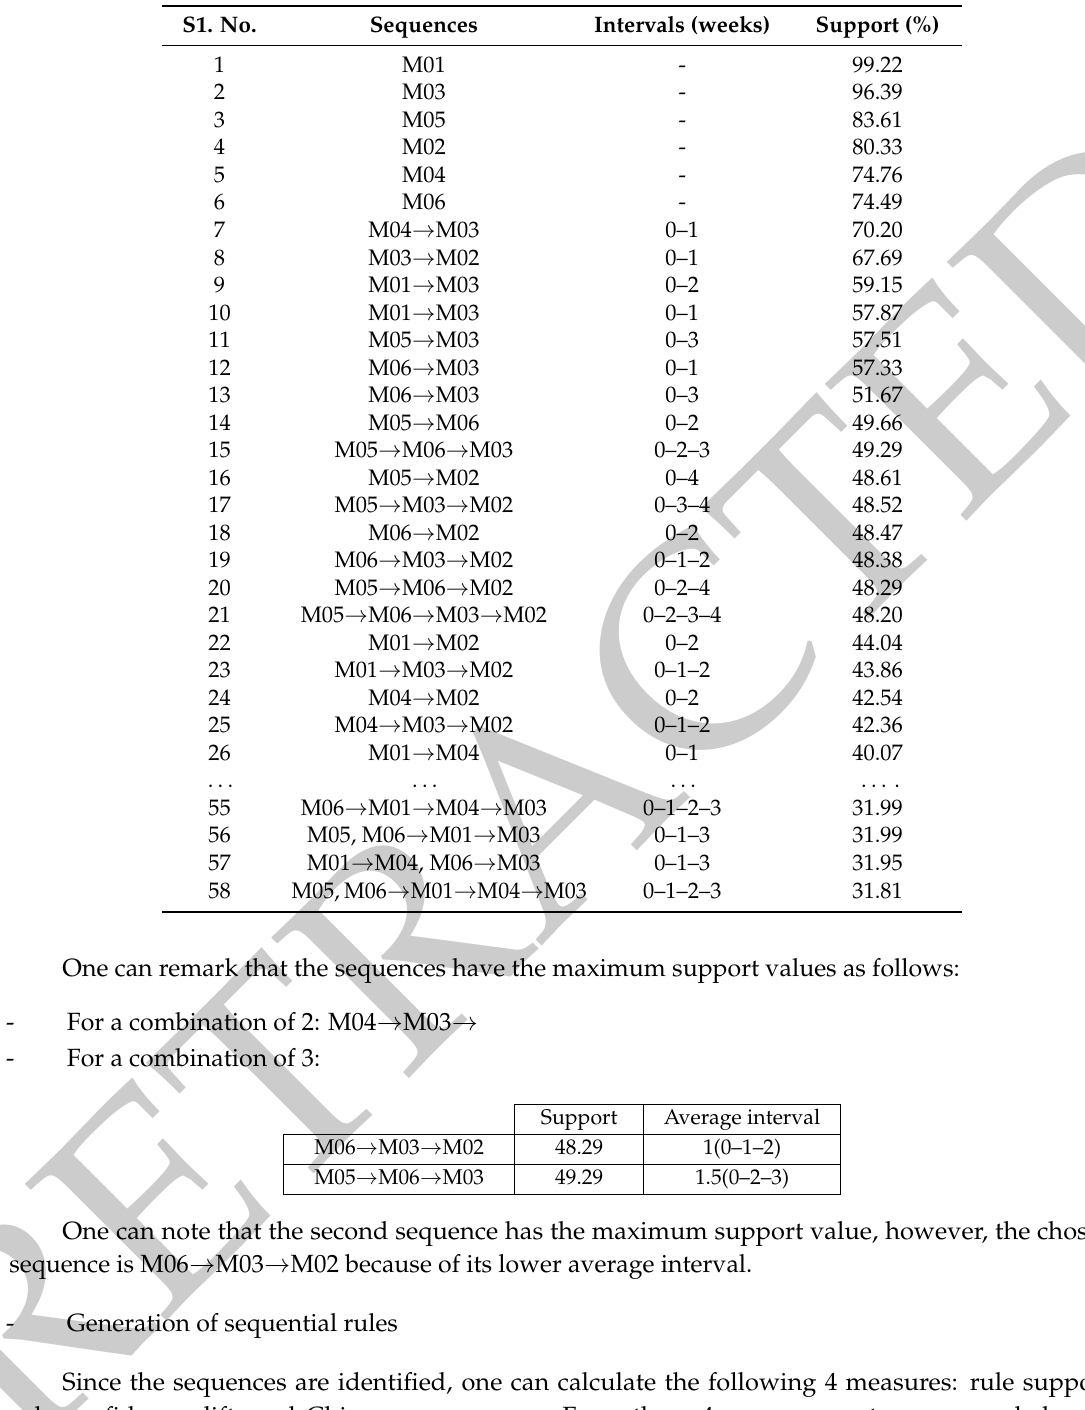
Table 7. The determined sequential